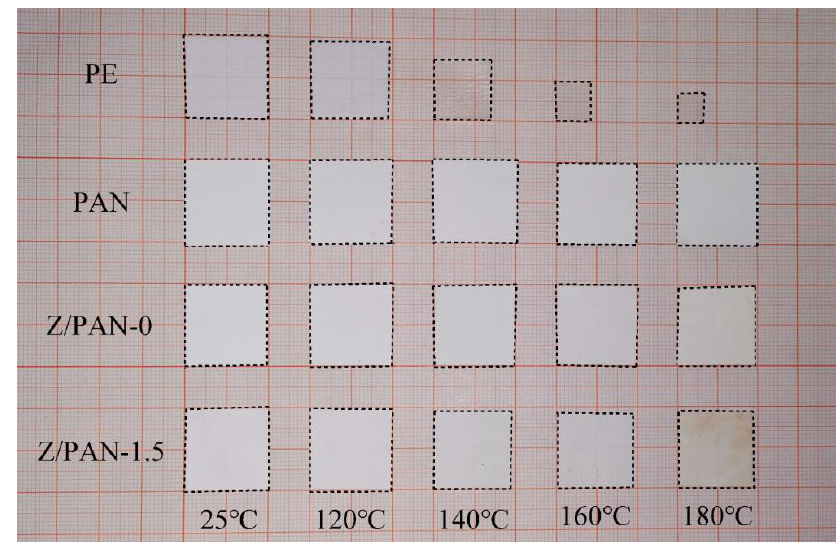
Figure 7. Thermal shrinkage of the separators observed at different temperatures.